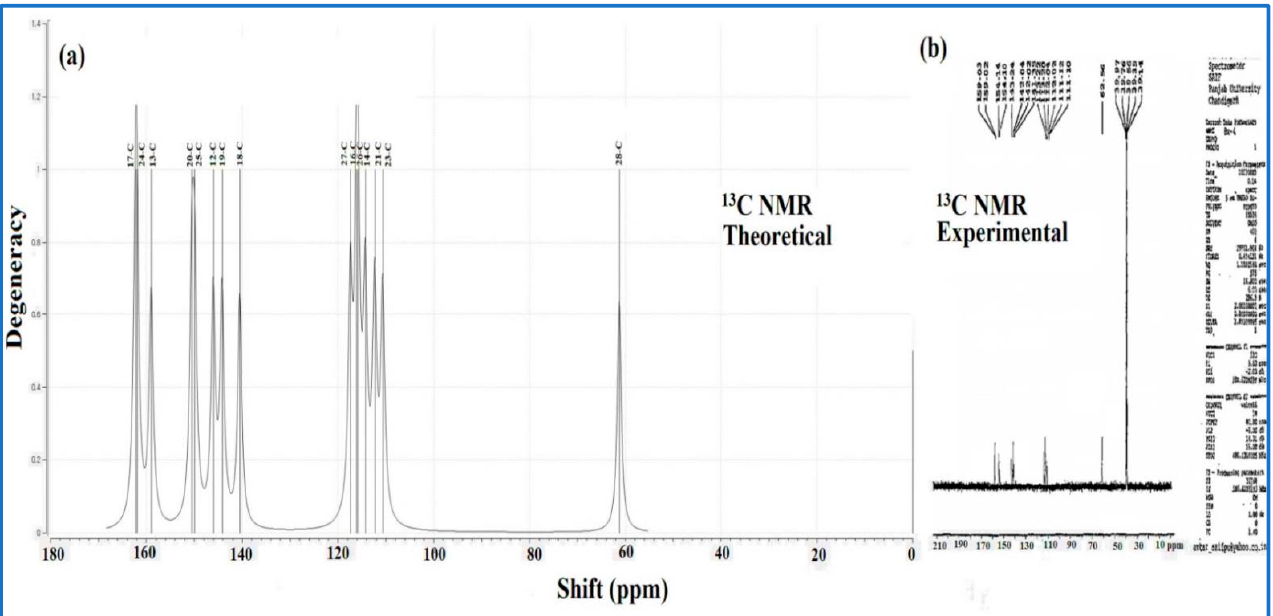
Figure 12. Calculated ( a ) and experimental ( b ) 13 C-NMR spectra of the isolated compound 2.